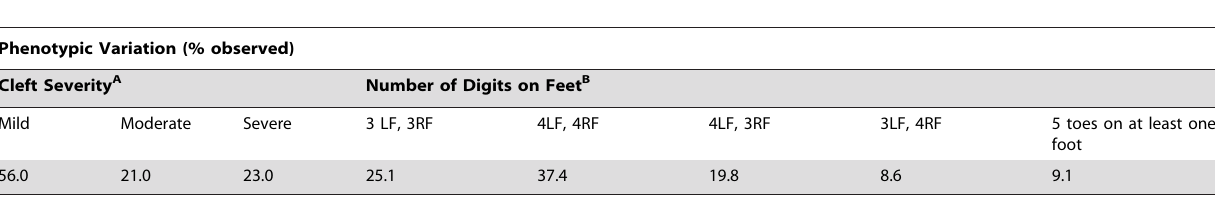
Table 5. Phenotypic variation is observed in the coloboma mutants for both cleft-palate and number of digits.